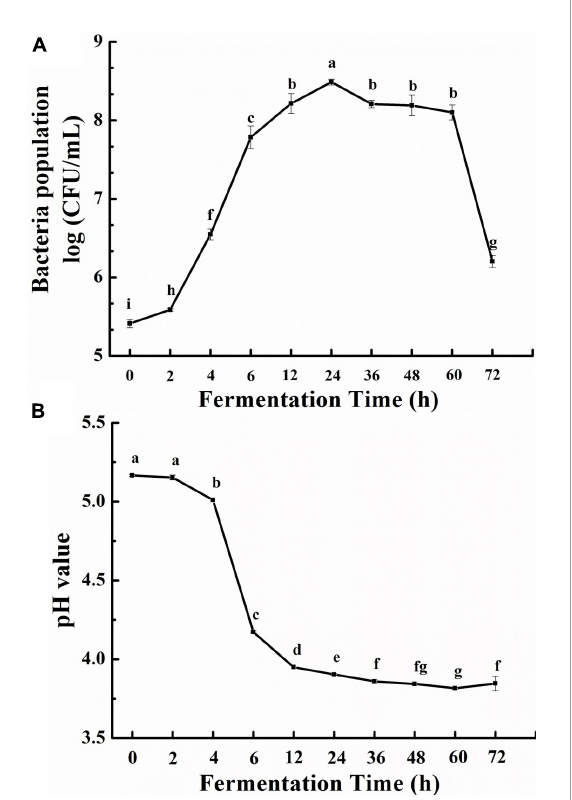
FIGURE1 Growth effects of litchi pulp on Lactobacillus fermentum with different fermentation times (A) , and the pH of litchi pulp cultures (B) . Mean ± SD ( n = 3). Different lowercase letters represent statistically significant differences among samples ( p <